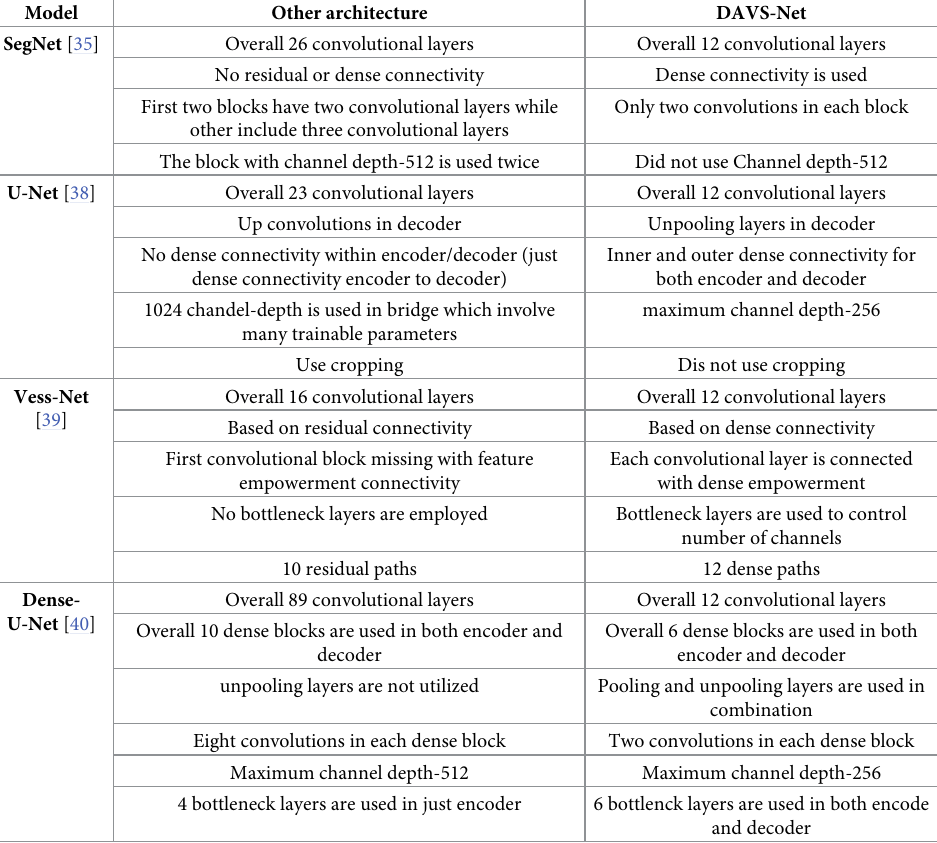
Table 3. Comparison of architectural differences with similar state-of-the-art